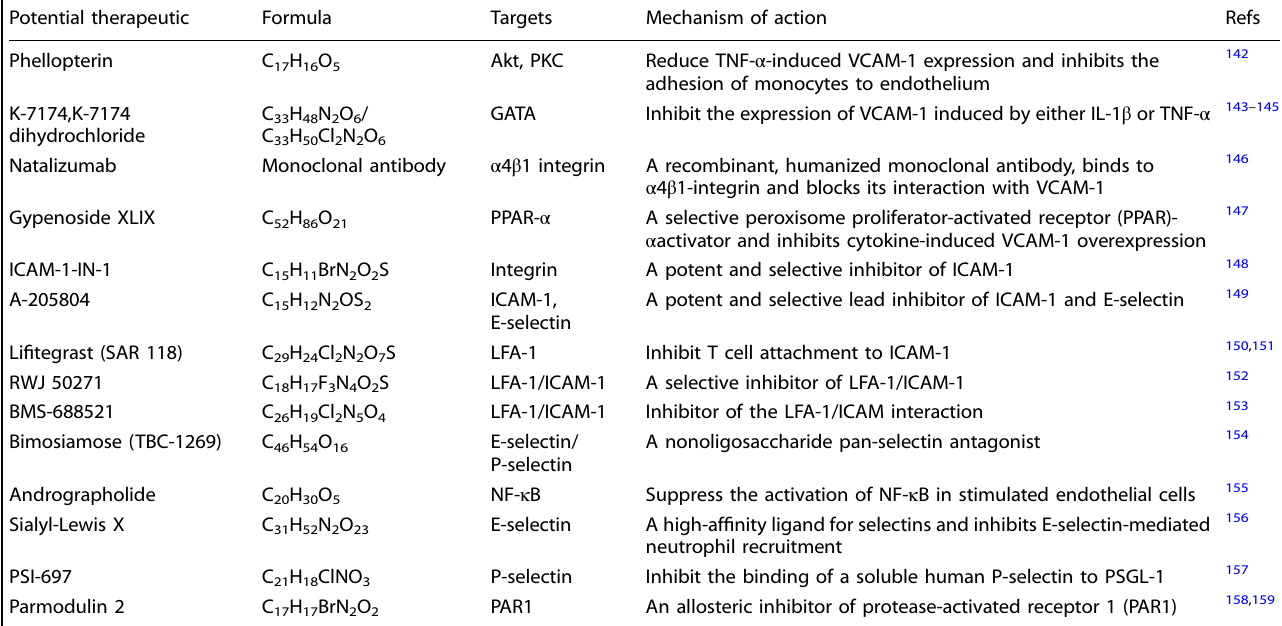
Table 2. Summary of existing pharmacological modulators that act directly or indirectly on endothelial activation-mediated leukocytes recruitment Potential